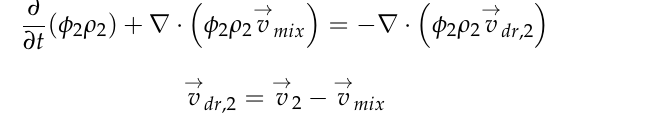
Table 1. The fluid properties and simulation parameters. Parameters Value Unit Density of water 1.0 × 10 3 kg/m 3 Density of fertilizer 1.3 × 10 3 Dynamic viscosity of water Dynamic viscosity of fertilizer Diameter of suspended